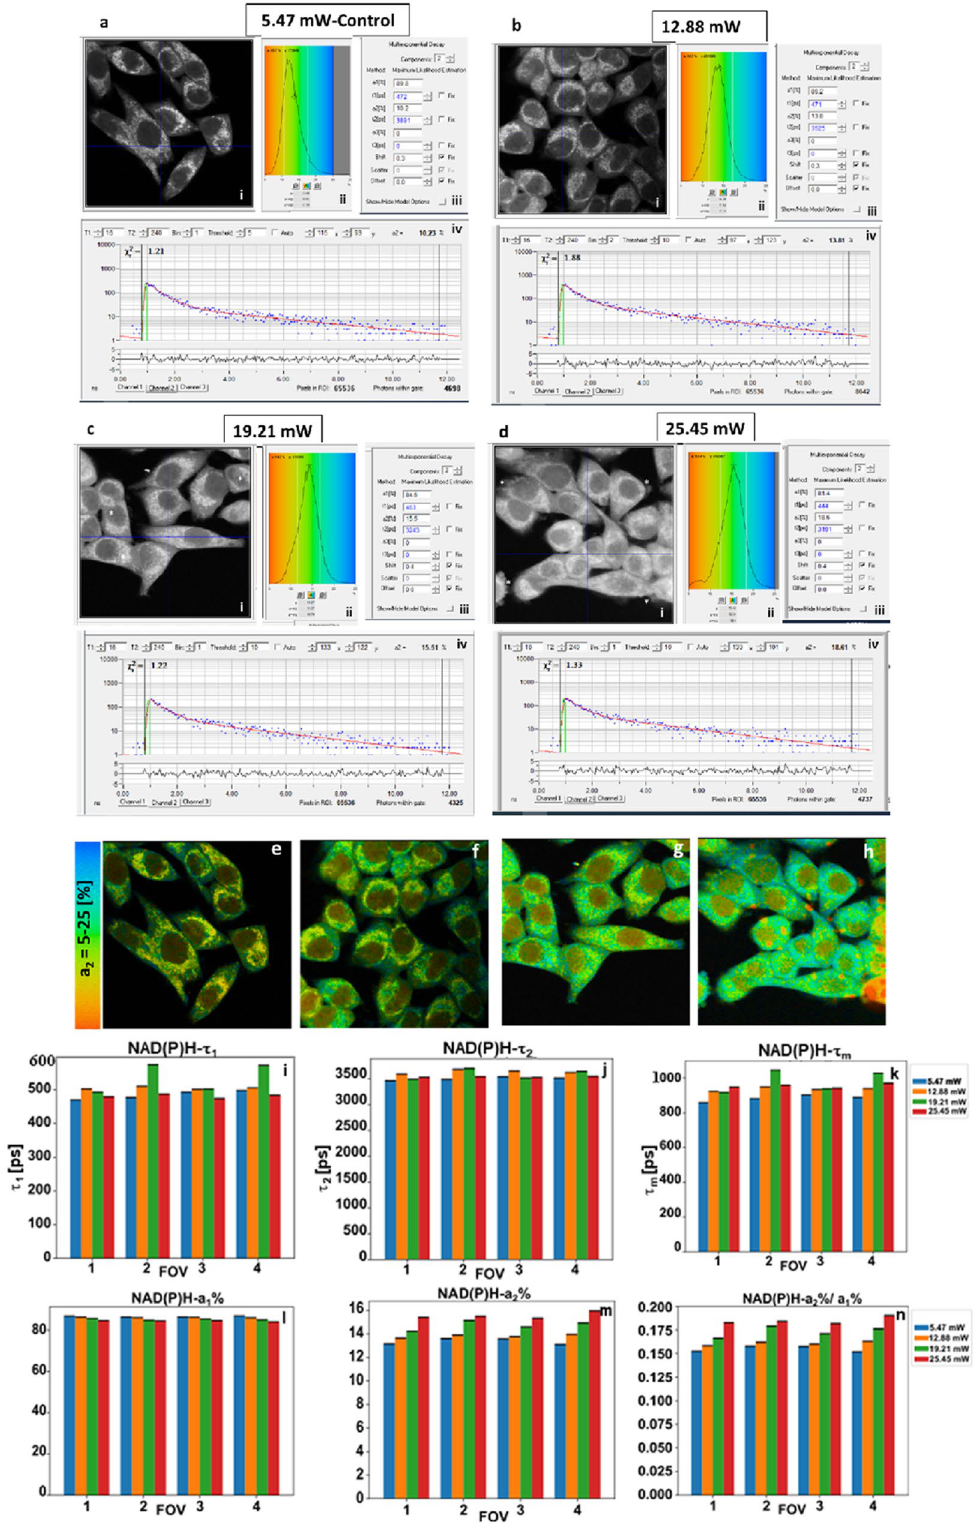
Figure 3. Mitochondrial OXPHOS metabolic marker NAD(P)H-a2% increases at rising 2p-740 nm laser average power in HeLa cells. Each panel ( a – d ) contains photon images (i) with corresponding NAD(P)H-a2% histogram (ii), lifetime parameters (iii) and the decay trace (iv). Panels ( e – h ) color-coded NAD(P)H-a2% images at different laser average power levels. Visually, mitochondrial morphology is clearly affected, confirmed later by mitochondrial viability markers (Figs. 4, 5 and 6). (i – n) Means (± SEM) of 4 merged FOVs (n = 70 cells) for several FLIM parameters. Except for natural cell variability, lifetimes τ 1 ( i ) and τ 2 ( j ) are unaffected by rising power, while NAD(P)H-a2%, the marker for OXPHOS metabolism increases ( m ), also affecting τ m , the amplitude-weighted-average lifetime ( k ). Rising NAD(P)-a2% also drives decreasing a1% ( l ) and increasing NAD(P)H-a2%/1% ratio ( n